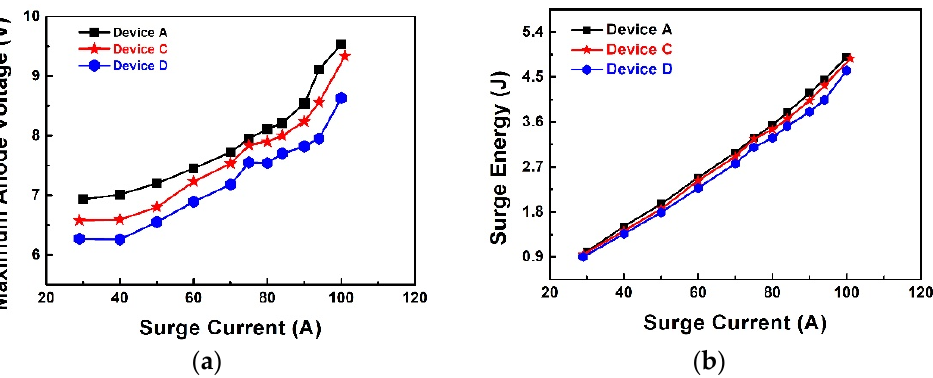
Figure 16. Summary of ( a ) maximum voltage and ( b ) dissipated energy at different surge current for Device A, Device C, and Device D.